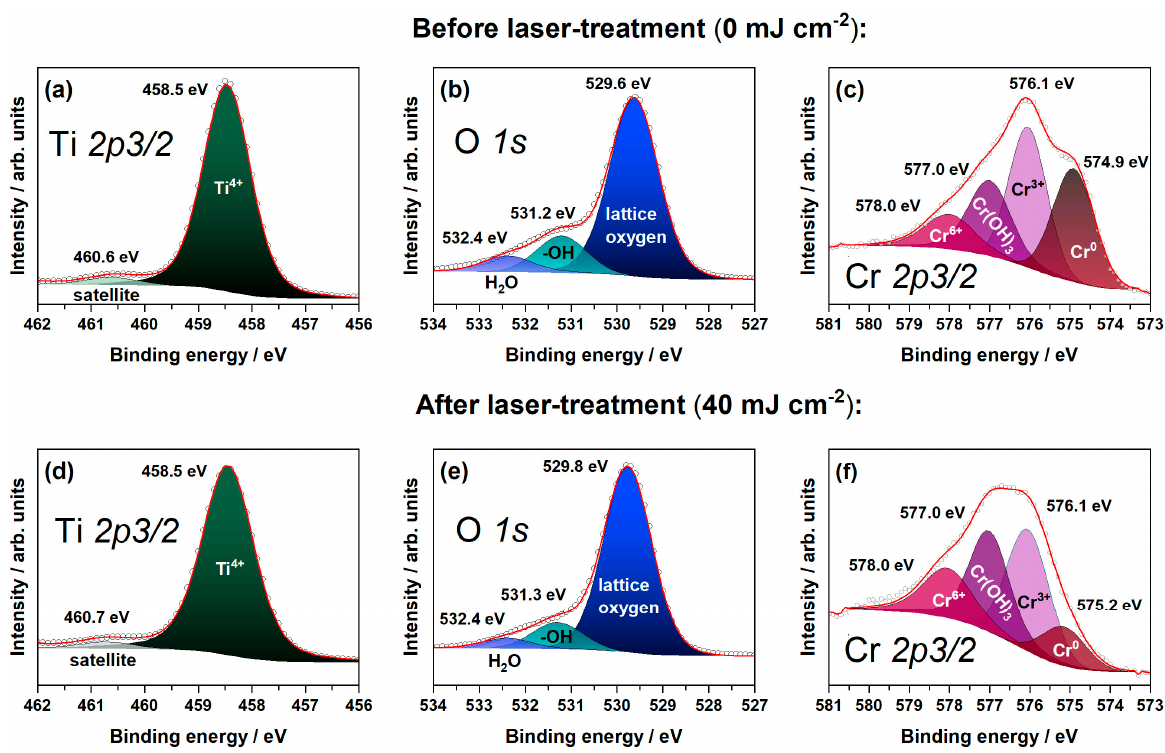
Figure 4. XPS spectra of the ( a , d ) Ti 2p , ( b , e ) O 1s , and ( c , f ) Cr 2p regions registered for the TiO 2 nanotubes decorated with chromium oxides ( a – c ) before and ( d – f ) after laser-treatment with 40 mJ cm − 2